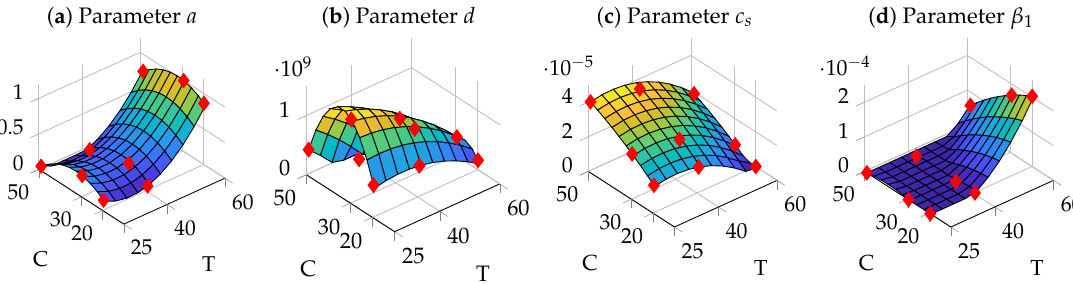
Figure 4. Polynomial dependencies of mechanistic parameters on temperature (T) and precursor concentration (C). Red diamonds indicate the parameter values at the provided experimental